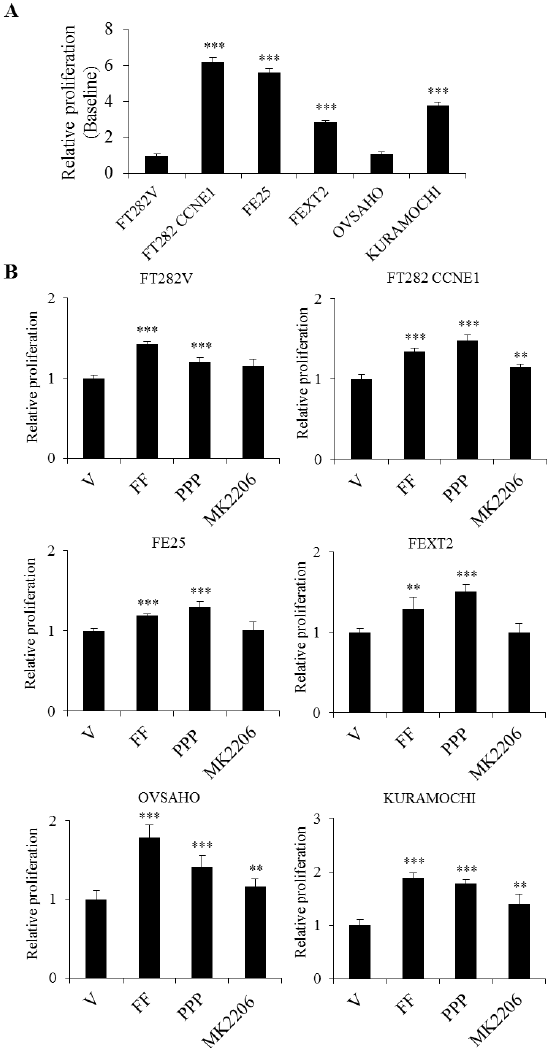
Figure 3. FF increases proliferation of transforming FTE /HGSC cells largely by AKT-signaling but not through IGF-1R. Under serum free conditions, cell proliferation was tested by XTT assay at baseline (no treatment) ( A ), and after treatment with vehicle, 10% FF (10%), FF + IGF-1R inhibitor (PPP) or FF + AKT inhibitor (MK2206) ( B ). Cells were harvested after 24 h. Results are from three independent experiments Error bar represents mean ± SD ( n = 8). The asterisk represents comparison of vehicle. ** p < 0.01, *** p < 0.001 by two-sided, unpaired Student’s t -test.